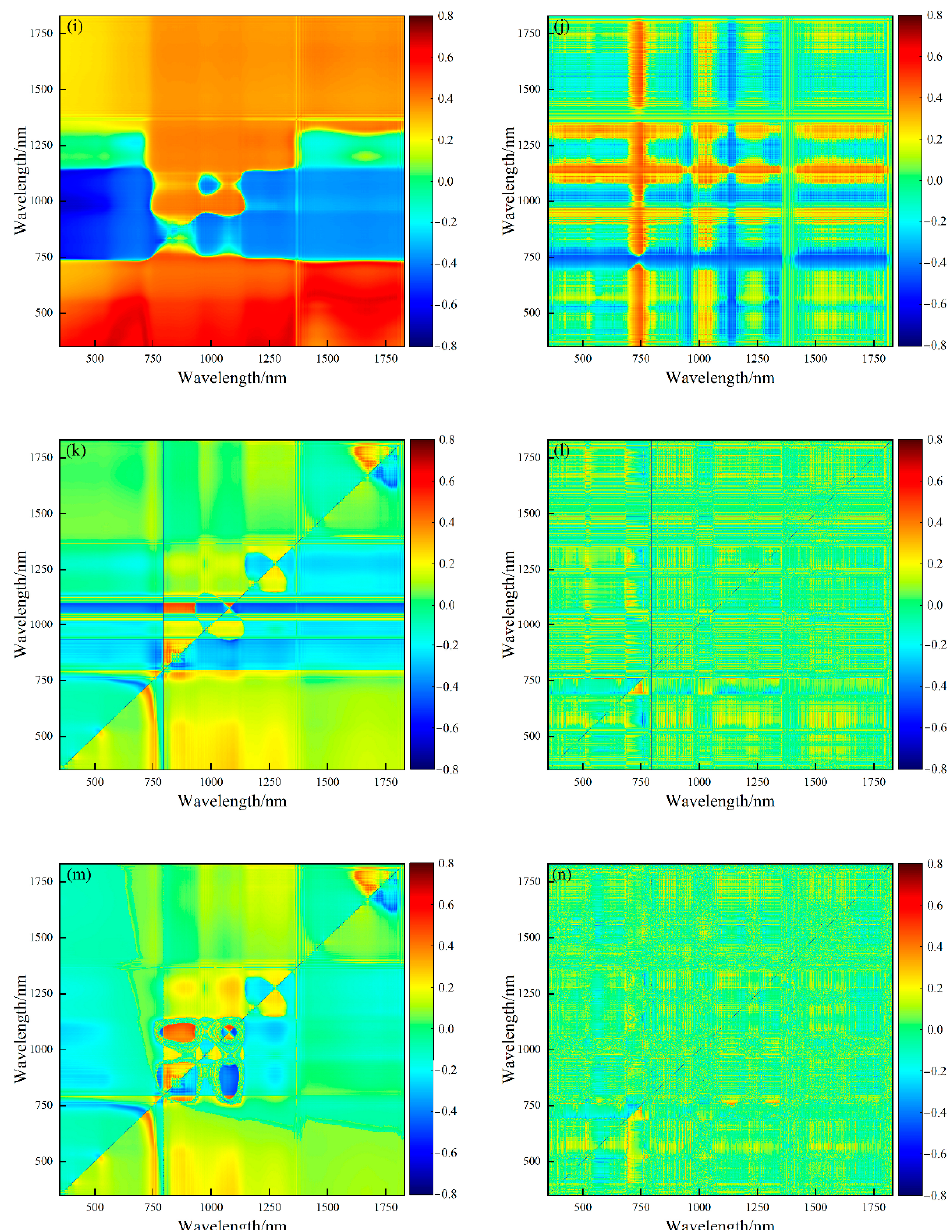
Figure 4. Correlation matrix diagram of spectral indices and above-ground biomass. ( a ) DI and above-ground biomass; ( b ) FDDI and above-ground biomass; ( c ) RI and above-ground biomass; ( d ) FDRI and above-ground biomass; ( e ) NDVI and above-ground biomass; ( f ) FDNDVI and above- ground biomass; ( g ) SAVI and above-ground biomass; ( h ) FDSAVI and above-ground biomass; ( i ) TVI and above-ground biomass; ( j ) FDTVI and above-ground biomass; ( k ) mSR and above-ground biomass; ( l ) FDmSR and above-ground biomass; ( m ) mNDI and above-ground biomass; ( n ) FDmNDI and above-ground biomass.